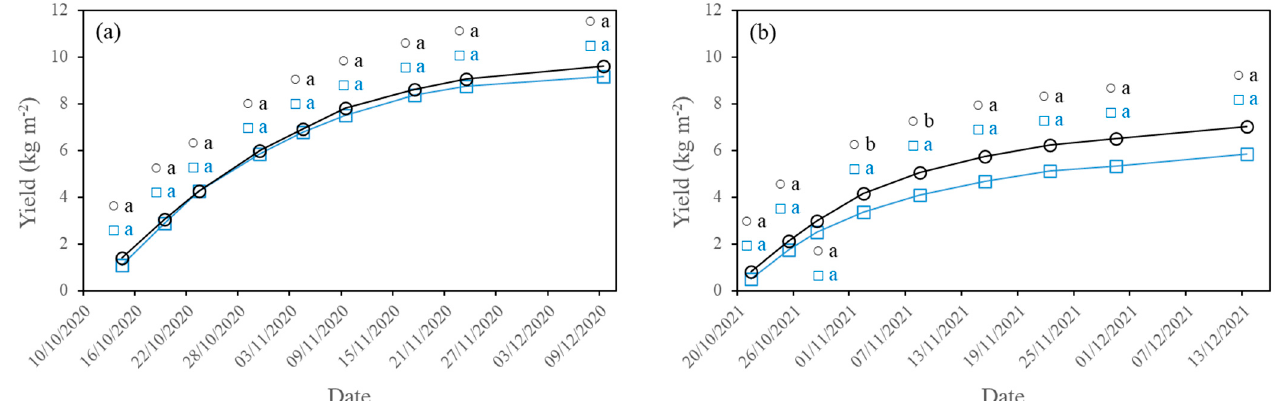
Figure 6. Cumulative production yield over time for the first crop cycle ( a ) and for the second crop cycle ( b ). Sector with commercial film C F ( □ ); Sector with experimental fi lm E F ( ○ ). Different letters indicate statistically significant difference ( p -value ≤ 0.95).